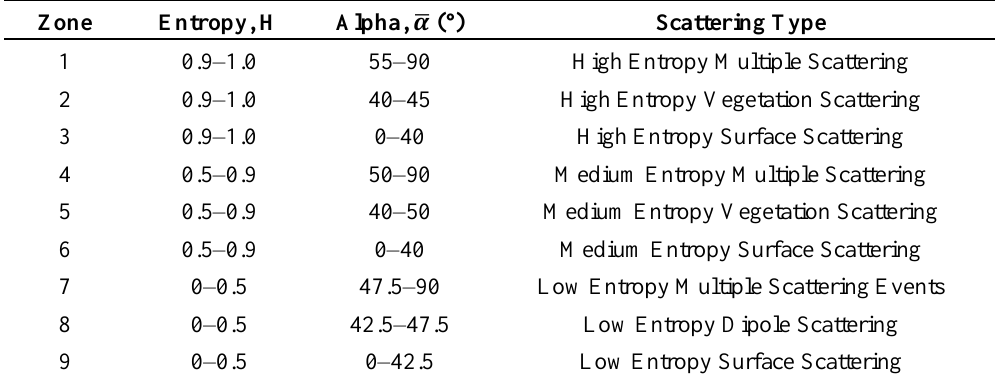
Table 2. The H- plane partioned into nine zone (adapted from Cloude and Pottier